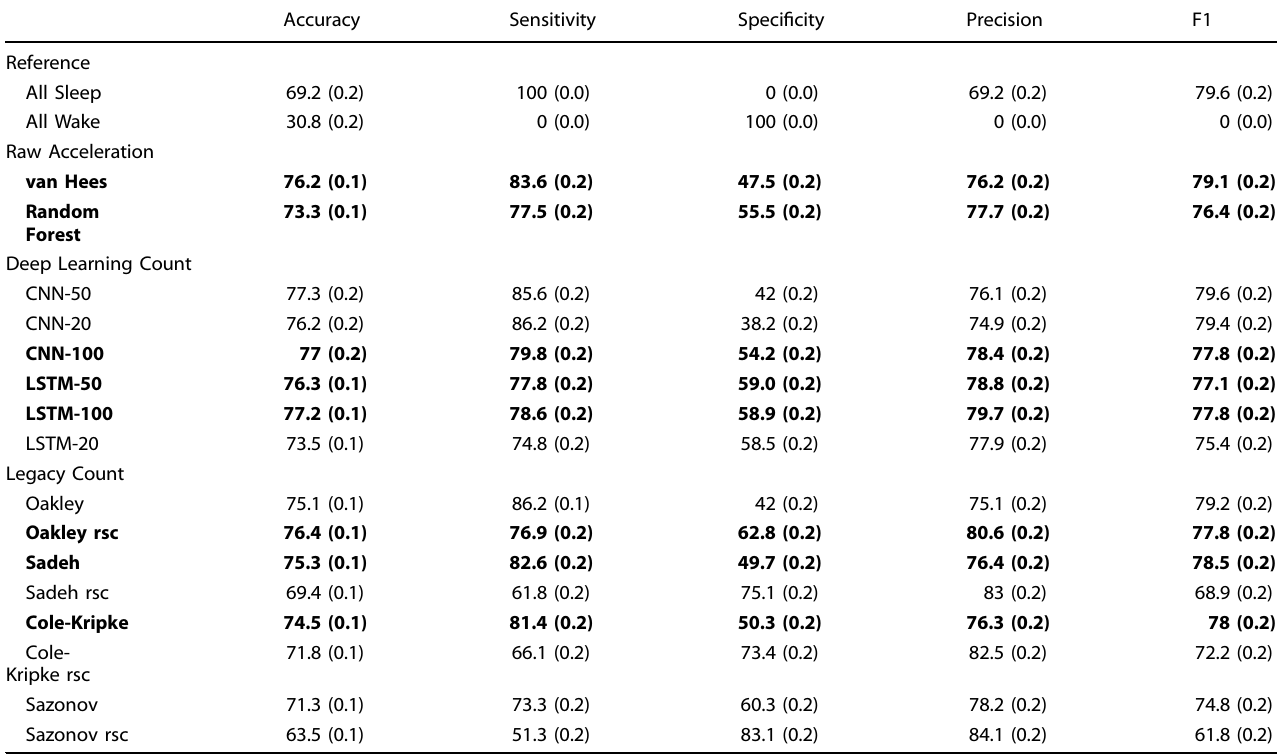
Table 1. Confusion matrix results for the binary classi fi cation problem of identifying sleep-wake from various algorithms compared to gold standard PSG